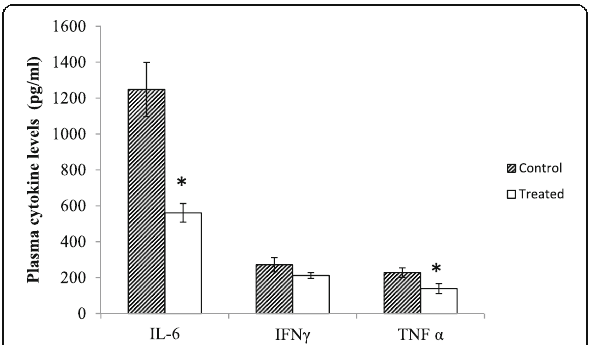
Fig. 3 Phagocytic activity of rat peritoneal macrophages following oral treatment of MLCC. Results are expressed as Mean ± SEM for the number of animals used ( n = 6/group). * p < 0.05 were considered significant when compared with the control (Mann Whitney U